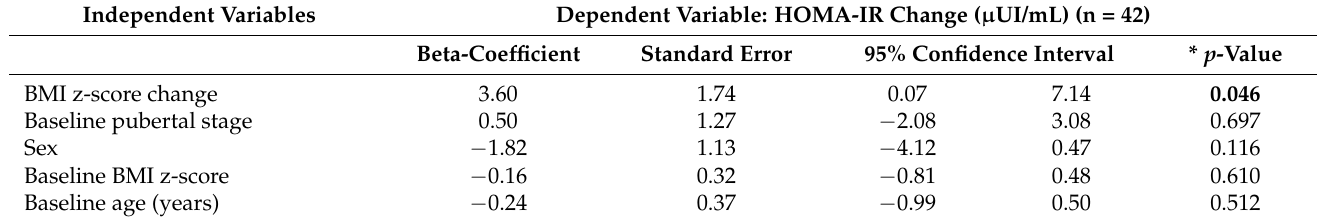
Table 5. Multivariate regression analysis results between BMI z-score change and HOMA—IR change.